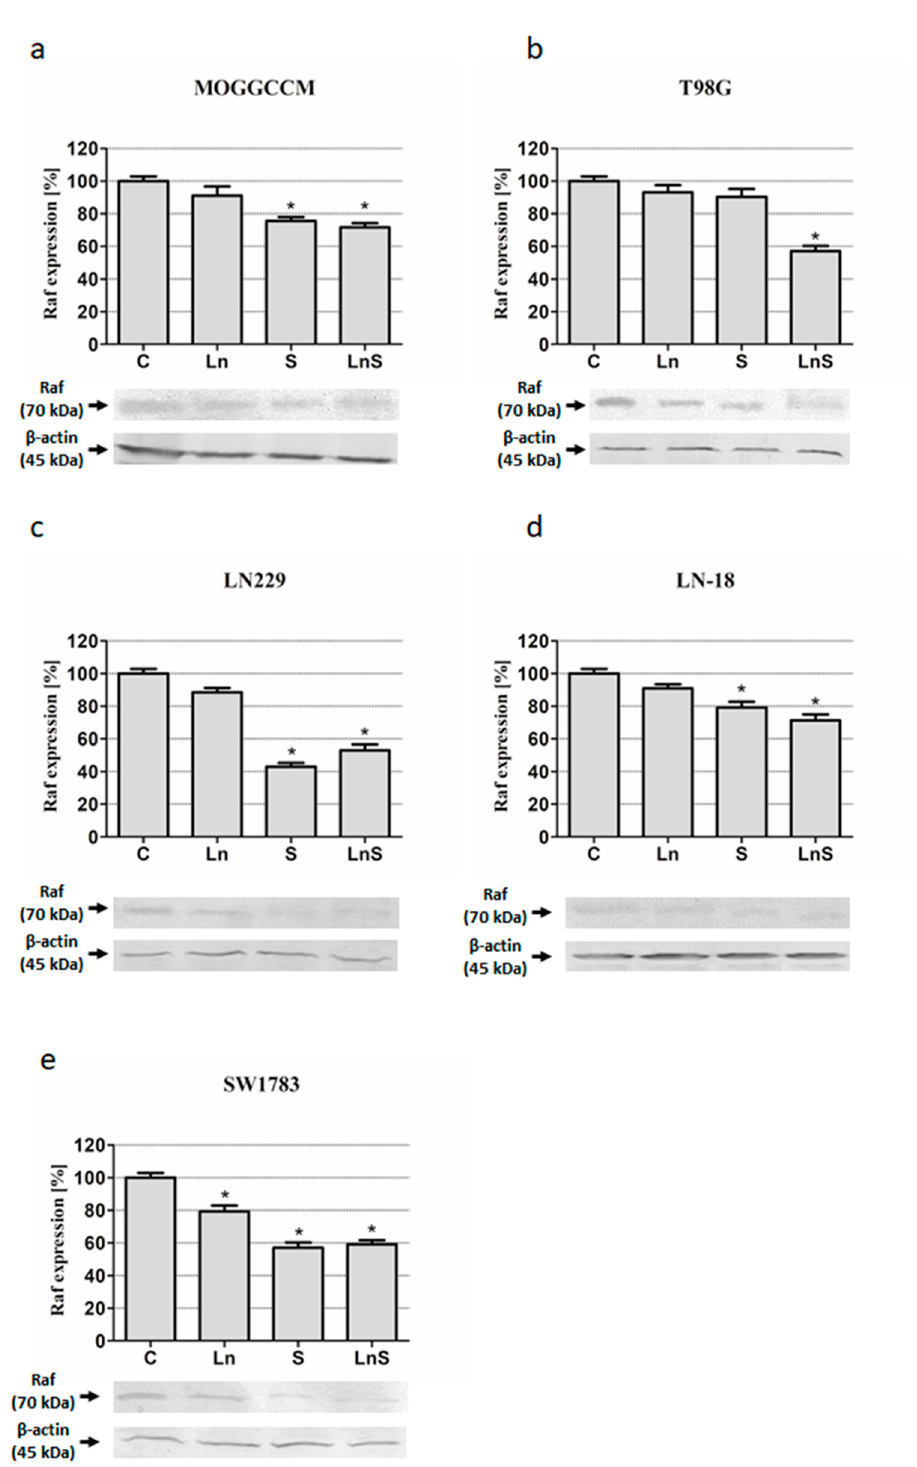
Figure 8. Level of Raf with representative blots in MOGGCCM ( a ), T98G ( b ), LN229 ( c ), LN-18 ( d ), and SW1783 ( e ) cells after treatment with lensoside A β (L) and sorafenib (S) applied alone or in combination (LS). C—control; * p < 0.01 compared to the control.